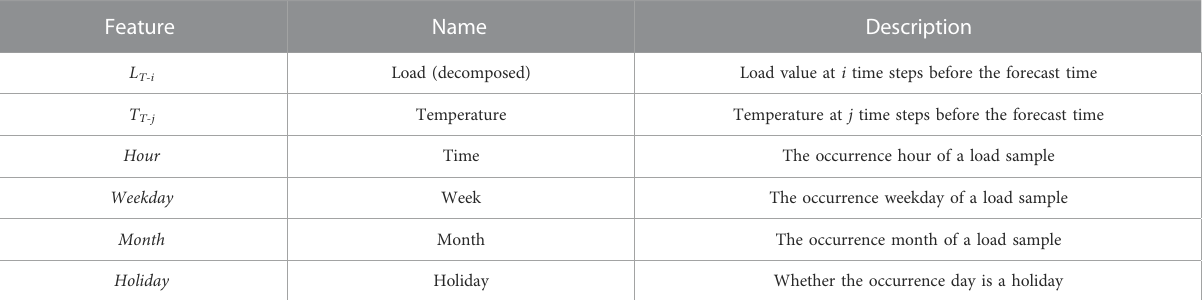
TABLE 1 Input feature